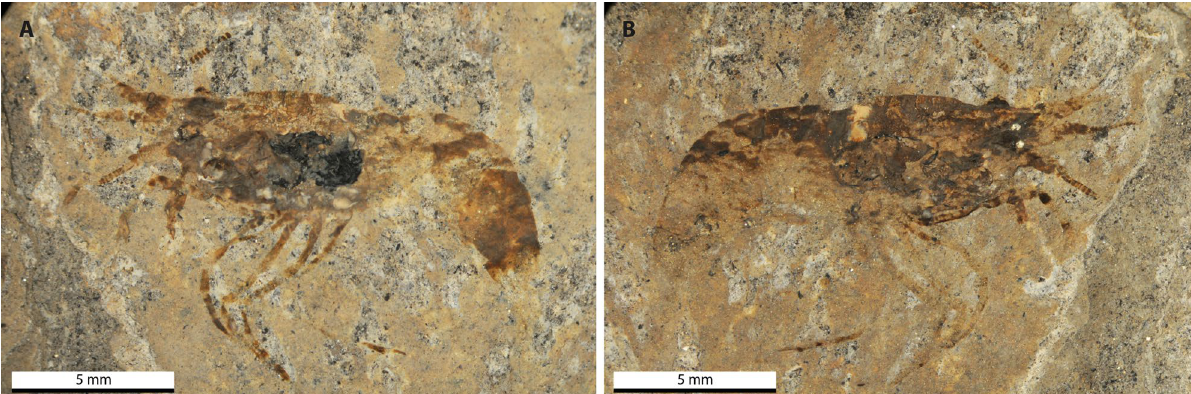
Figure 2. Photograph of the holotype of Bechleja brevirostris n. sp. (SF-MeI 5933). ( A ) Plate; ( B ) counterplate.